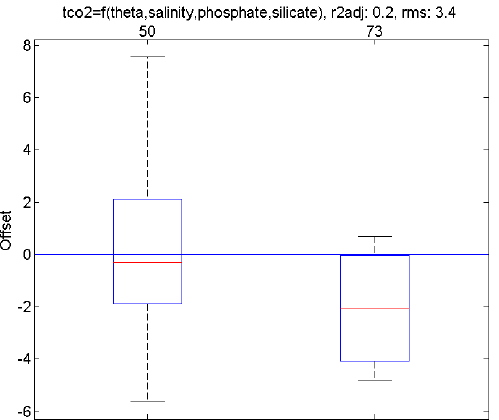
Figure 4. MLR results for TCO 2 in the Amundsen Basin (o ff sets in µ molkg − 1